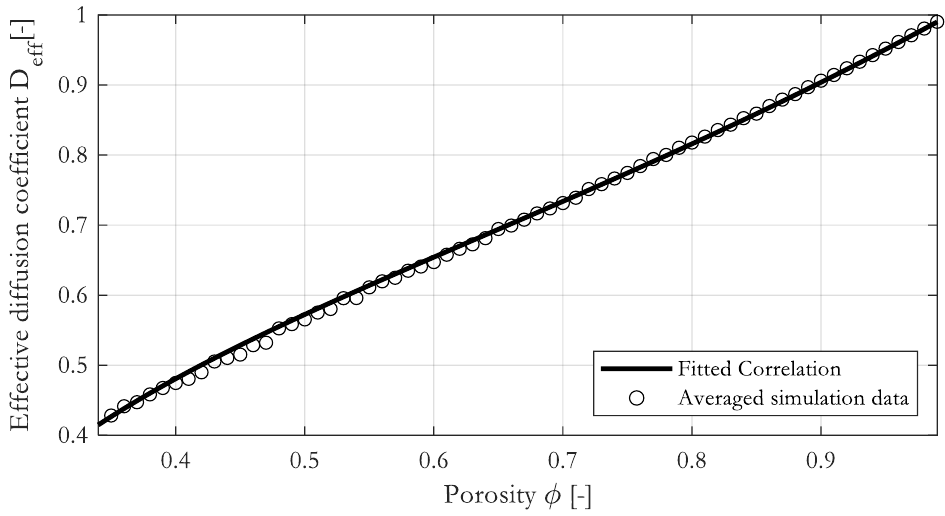
Figure 13. Constitutive diffusion – porosity correlation with geometrical mean of simulation data.